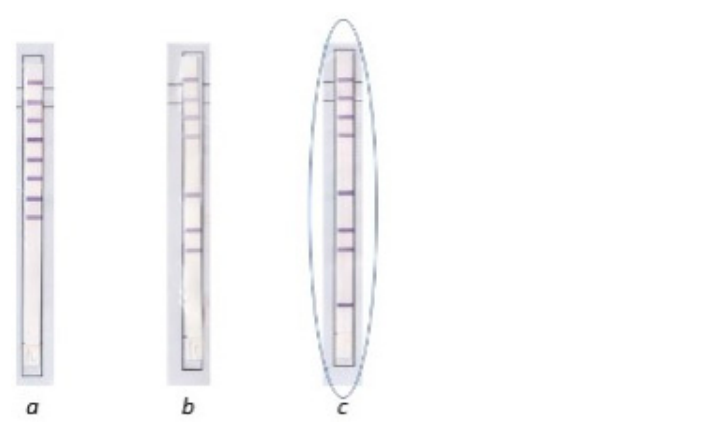
Figure 4. Result of molecular identification of MTBC strains by Hain Lifescience, Nehren, Germany. ( a ) Mycobacterium tuberculosis ; ( b ) Mycobacterium bovis; ( c ) Mycobacterium bovis BCG.